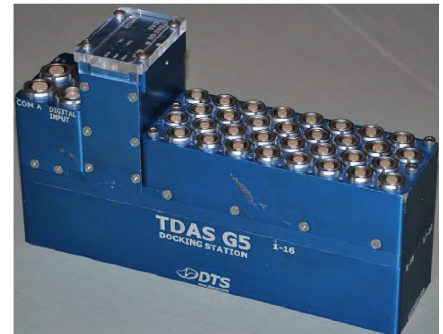
Figure 19: Acquisition instrument.